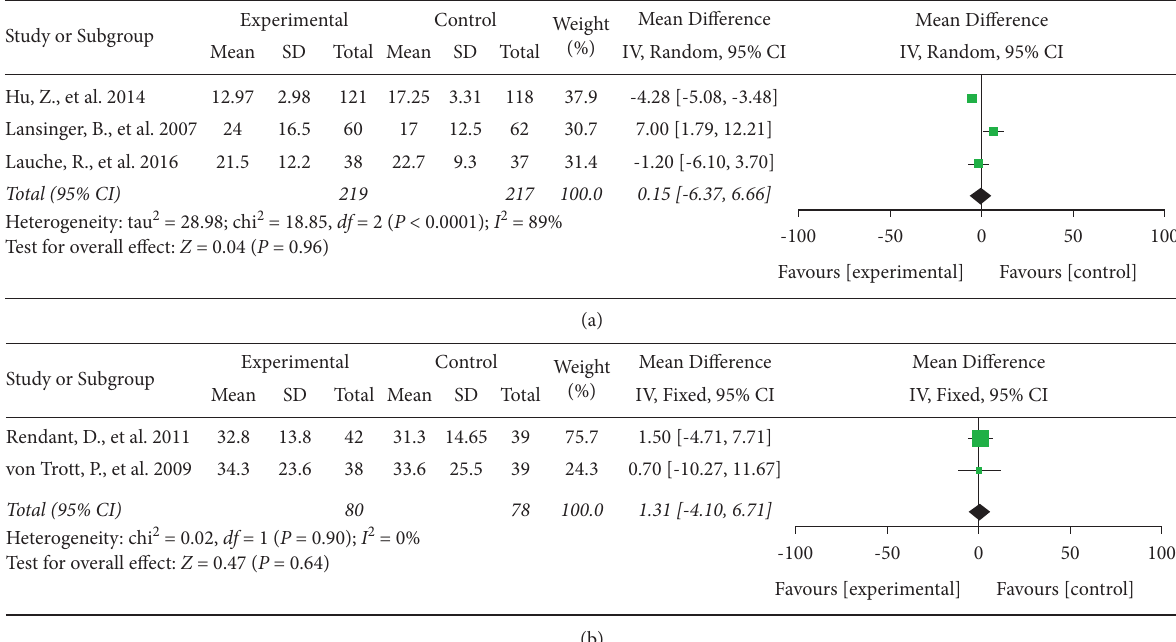
Figure 3: Effects of TCMBE on functional mobility. TCMBE: traditional Chinese mind and body exercise; NDI: neck disability index; NPDS: neck pain and disability